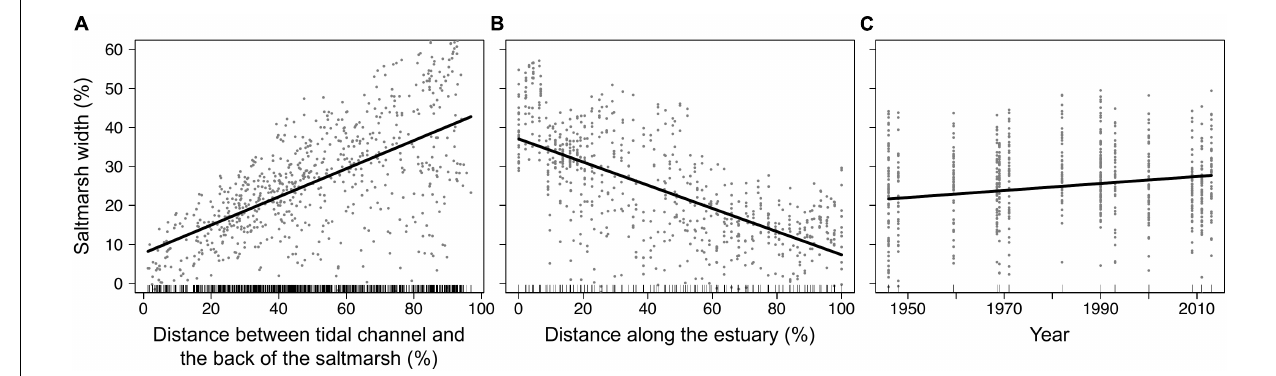
FIGURE 7 | Relationships between the marsh width and key predictor variables: (A) Distance from the back of the marsh to the nearest tidal channel, (B) distance along the estuary from top (left) to bottom (right), and (C) year of survey (identified from a mixed effects model with “estuary” as a random intercept; Table 1 ). Measurements were standardized as a percentage of estuarine width [all y-axes and x-axis of (A) ] or estuarine length [x-axis of (B) ]. Data points represent distribution of standardized partial residuals. Solid lines represent model fit though the data. Tick marks along the bottom of each plot denote deciles of the distribution of each predictor value. See Supplementary Figure 5 for the interaction effect of channel and marsh position on the width of marshes.